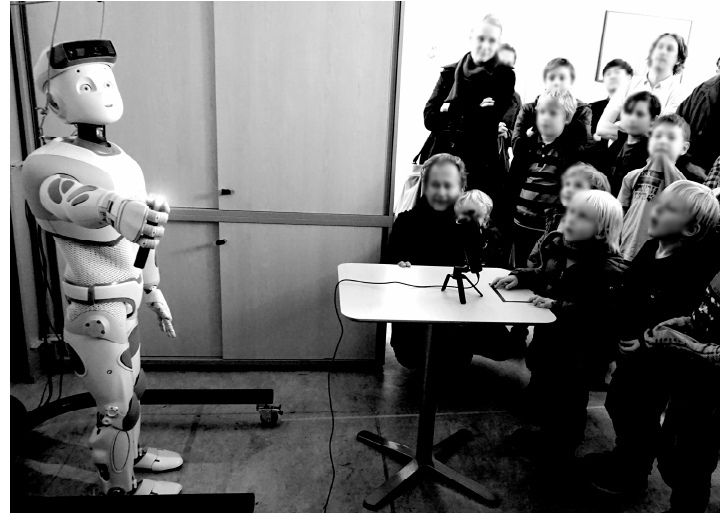
Figure 1. Robot Romeo in the experimental setting at the “Long Night of the Robots” at Vienna University of Technology.